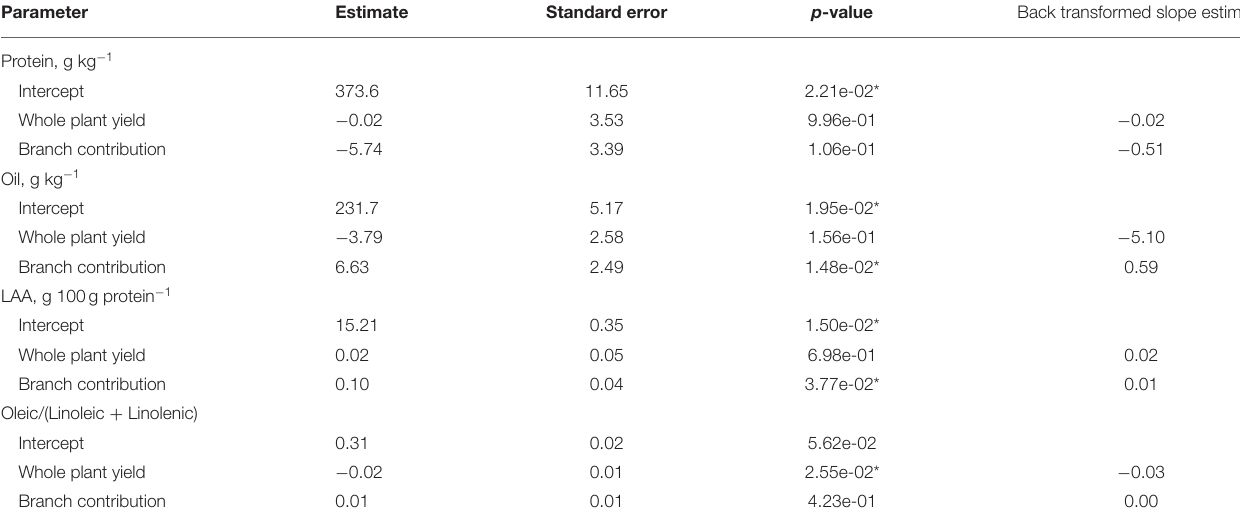
TABLE 2 | Whole plant soybean seed protein, oil, and limiting amino acids (LAAs) concentration, and oleic/(linoleic + linolenic) ratio as a function of whole plant yield (Mg/ha) and branch contribution to the whole plant yield (%). Parameter